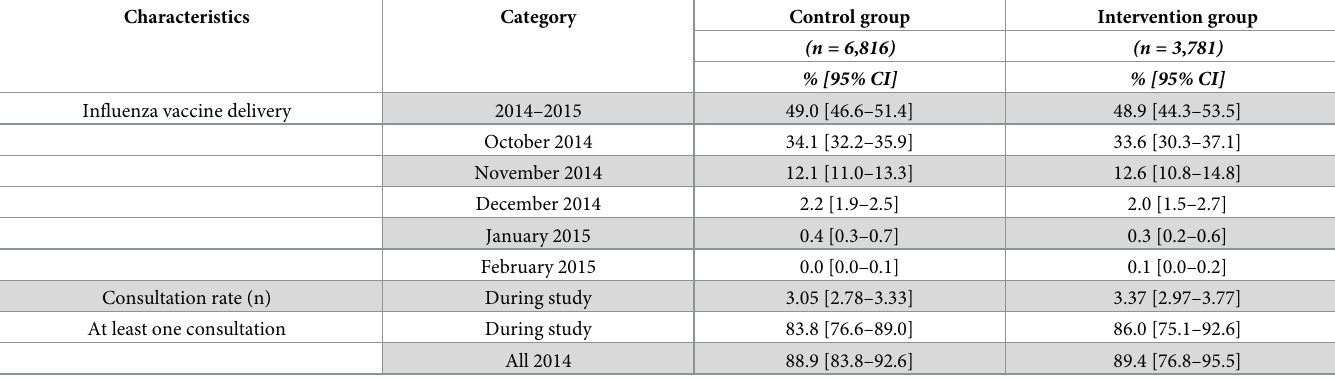
Table 2. Study characteristics (October 2014-February 2015) by study